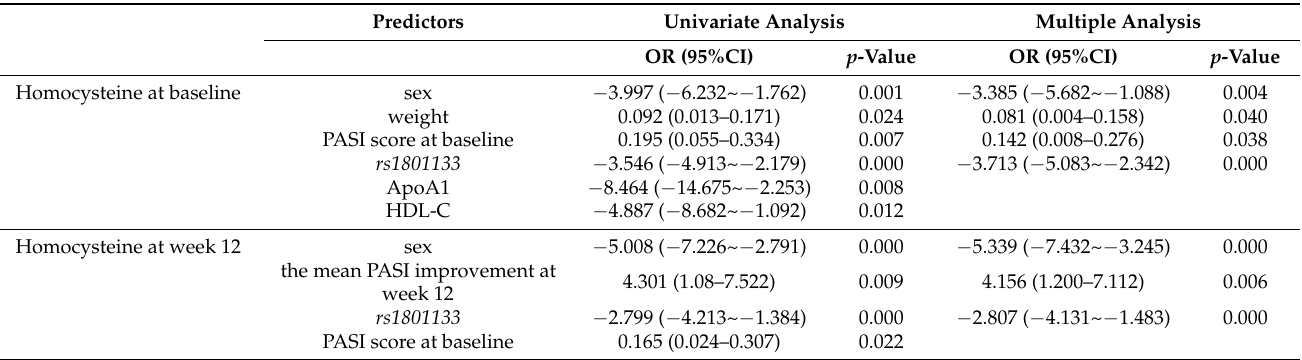
Table 2. The factors associated with serum homocysteine level at baseline and week 12 in univariate analysis and multiple